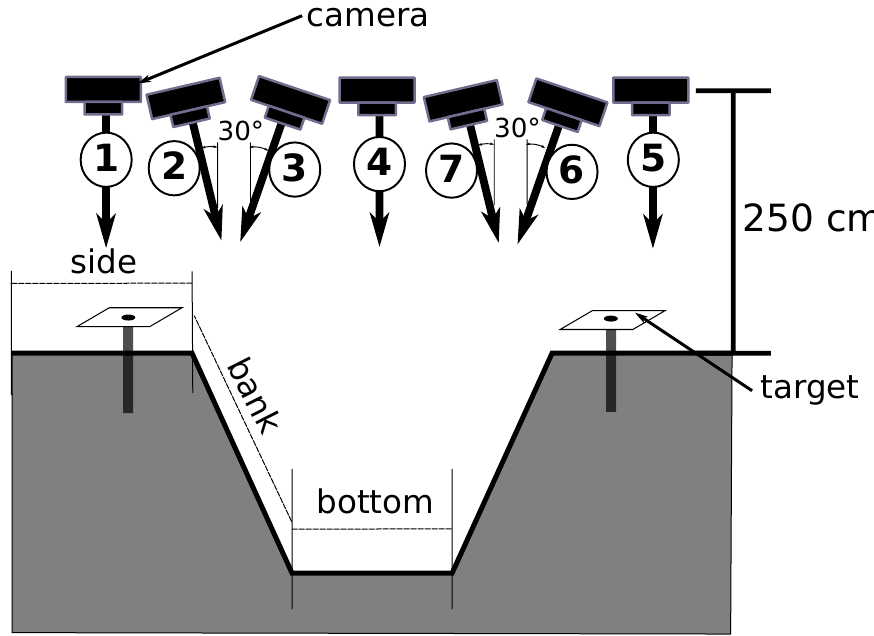
Figure 2. Order of passages and orientation of the pole during SfM-MVS acquisition. The numbers from 1 to 7 in the upper part of the image stand for the order of passages of the cameras. Angles of the oblique imagery for the passages 2–3 and 6–7 are indicated, the passages 1, 4, 5 being realized in nadir. 2.4. SfM-MVS Processing Chain for Generating the DTM, DSM and